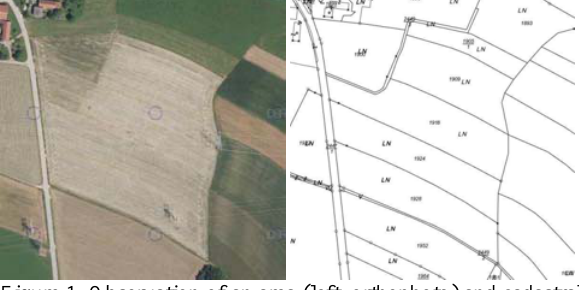
Figure 1: Observation of an area (left, orthophoto) and cadastral data of the same area